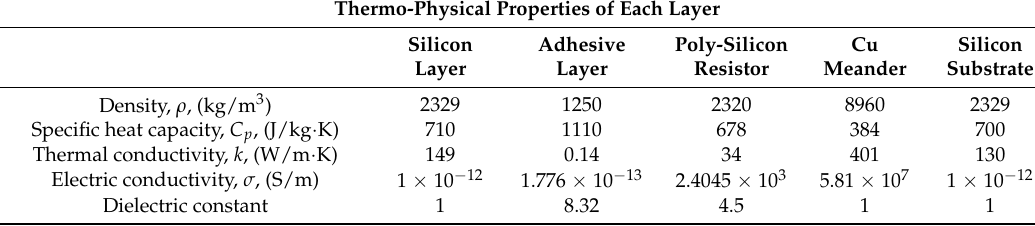
Thermo-Physical Properties of Each Layer Silicon Adhesive Poly-Silicon Cu Silicon Layer Layer Resistor Meander Substrate